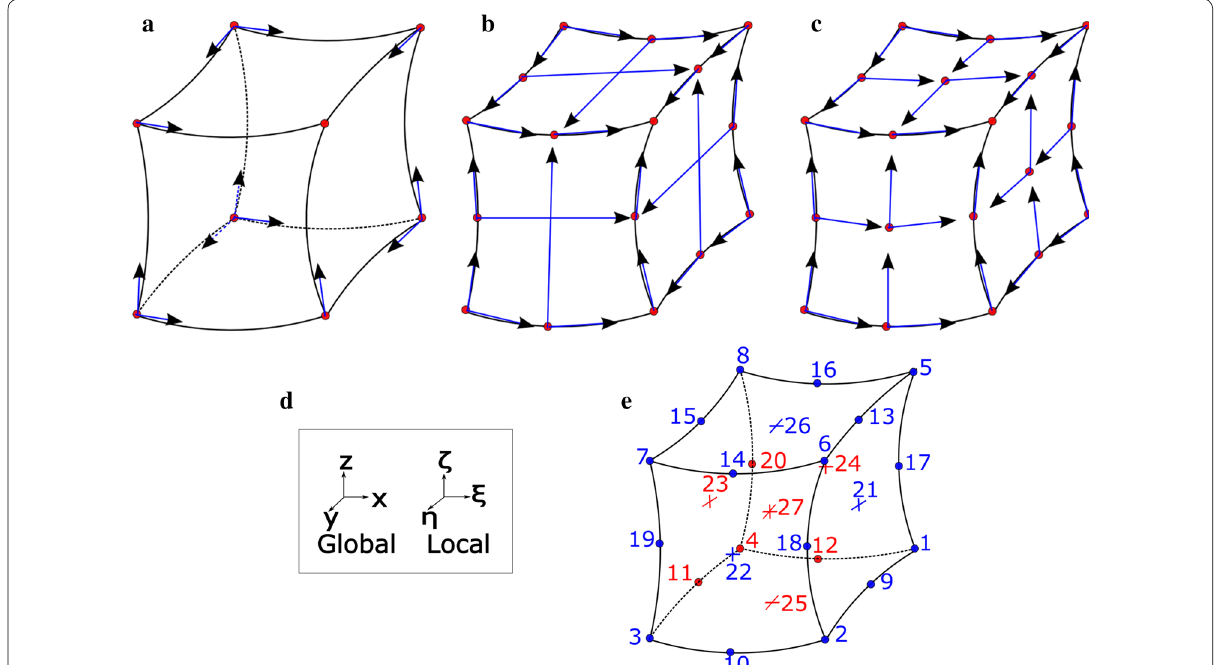
Fig. 1 Edge elements and nodes on the basis hexahedron. a Linear‑order elements, n n = 8 , n e = 12 (Kameari 1990). b High‑order (quadratic) elements, n n = 20 , n e = 36 (Kameari 1990). c High‑order covariant projection (Lagrangian) elements, n n = 27 , n e = 54 (Crowley et al. 1988). d Coordinate systems orientations. e Enumeration scheme for element nodes and element edges is internally enumerated depending on the numerical